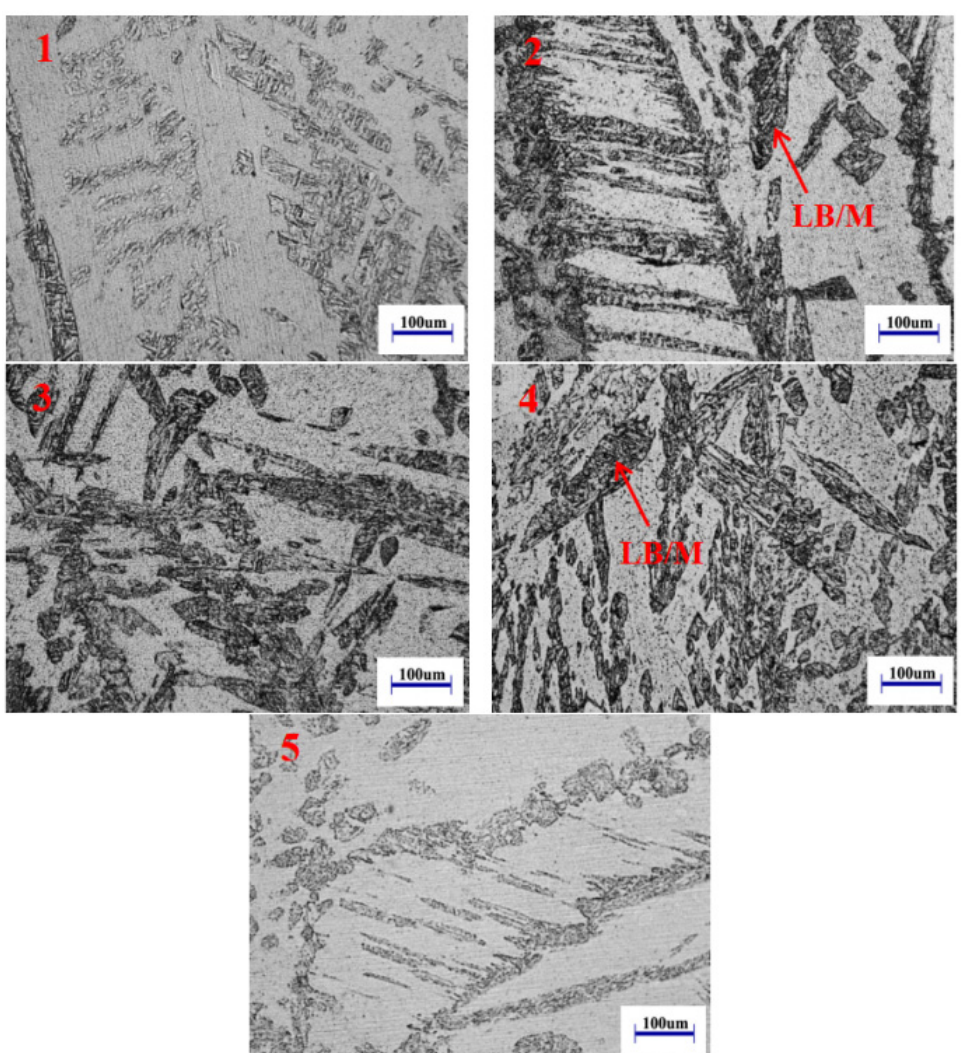
Figure 10. Microstructure of weld zone at different heat treatment temperatures: ( 1 ) as-welded, ( 2 ) 720 °C, ( 3 ) 770 °C, ( 4 ) 820 °C, ( 5 ) 870 °C .